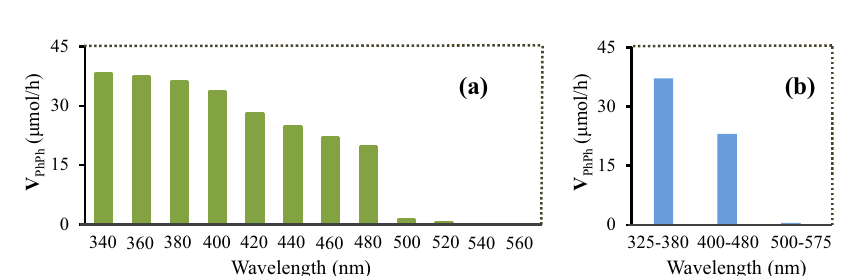
Fig.4|Couplingofbromobenzeneunderdifferentwavelengthsoflight.a Effect of different monochromatic lights on the produced rate of biphenyl. x nm wave- length represents x±10nm wavelength. b Effect of different polychromatic lights